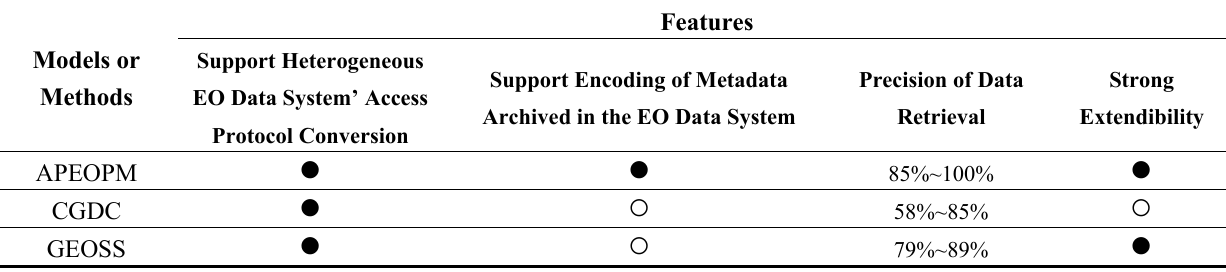
Table 4. Comparisons with other